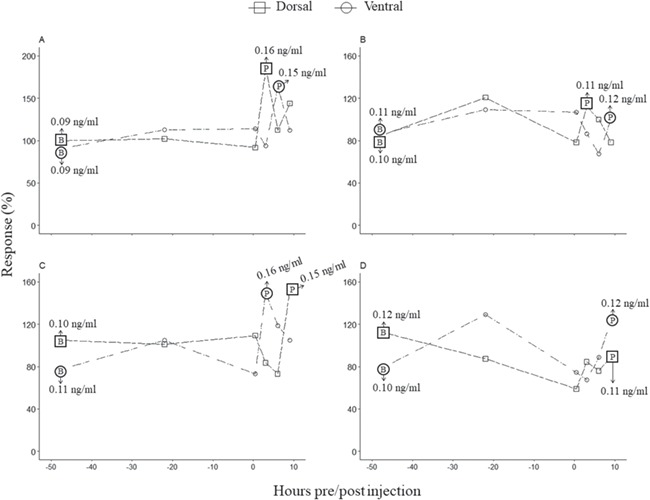
The percent dGC response for one ACTH injected female (A) and male (C), as well as one control female (B) and male (D), from both the dorsal and ventral regions. The ACTH and Ringer’s solution administration occurred at time 0. The calculated baseline (B) and peak post injection (P) absolute dGC concentrations are shown.